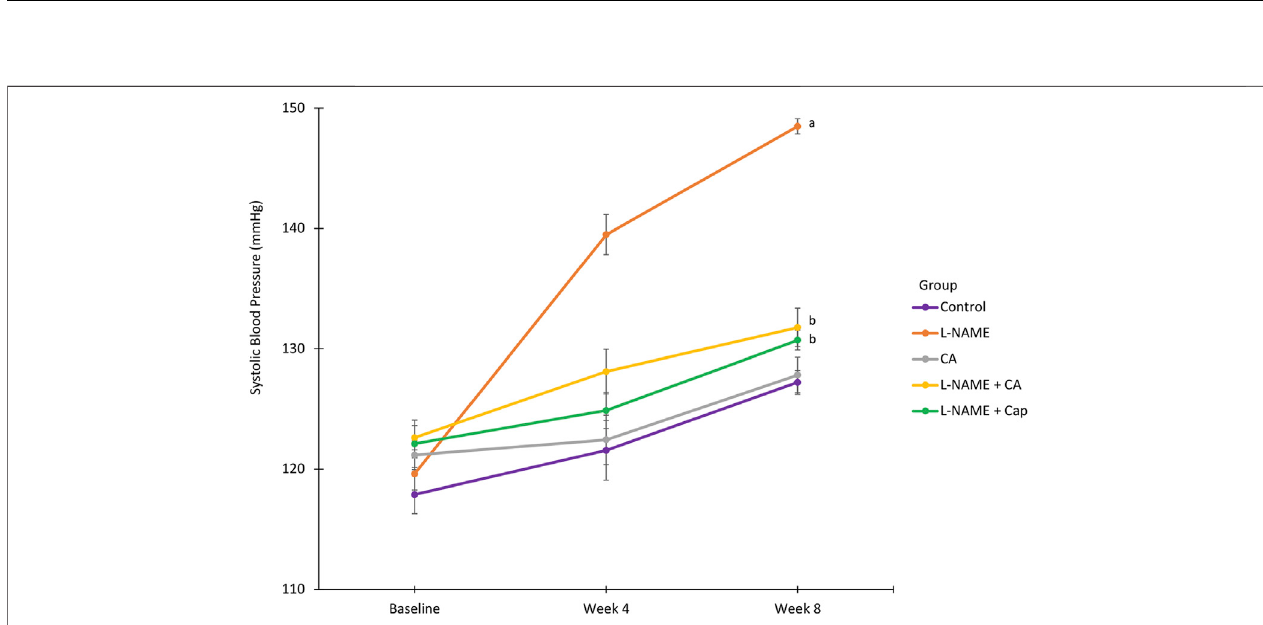
FIGURE 2 | Systolic blood pressure in rats treated with concurrent L -NAME (40 mg/kg orally) and C. asiatica (500 mg/kg orally) or captopril (5 mg/kg orally). Line graph represent mean ± SEM ( n (cid:1) 6). a versus control ( p < 0.05), b versus L -NAME ( p < 0.05).